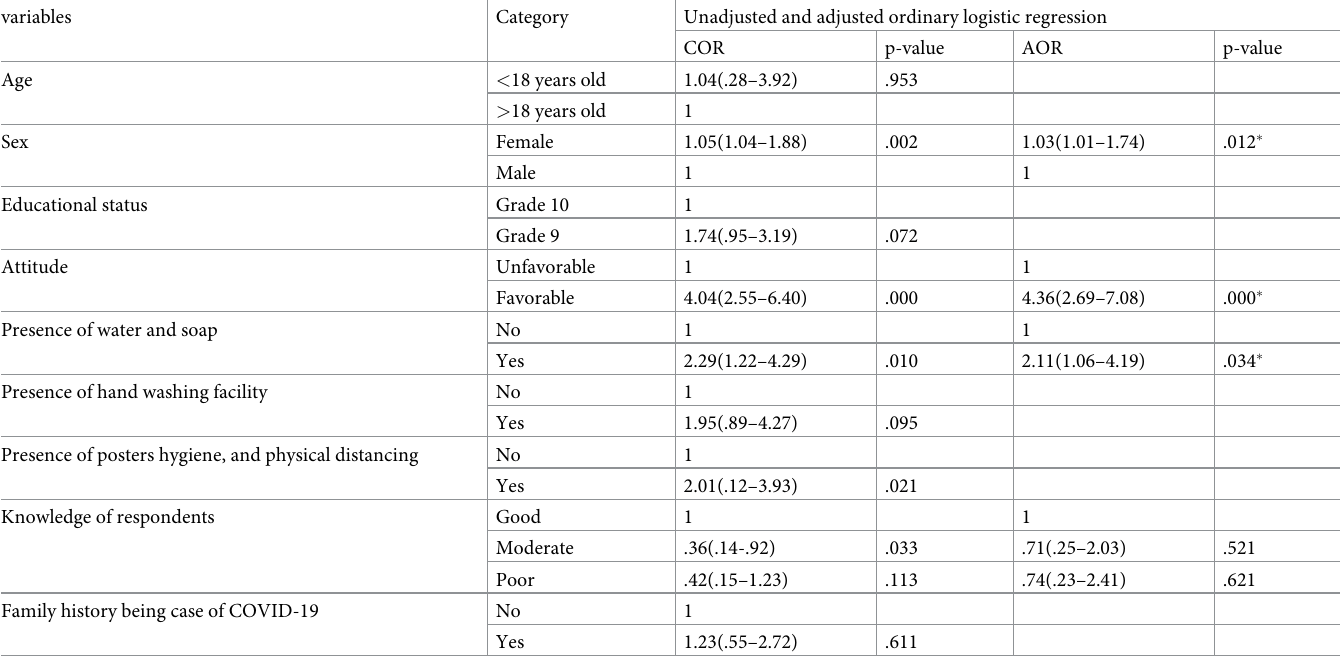
Table 7. Factors affecting COVID-19preventive adherence among students of Jimma town public high schools, southwest Ethiopia/2021 (n = 388).